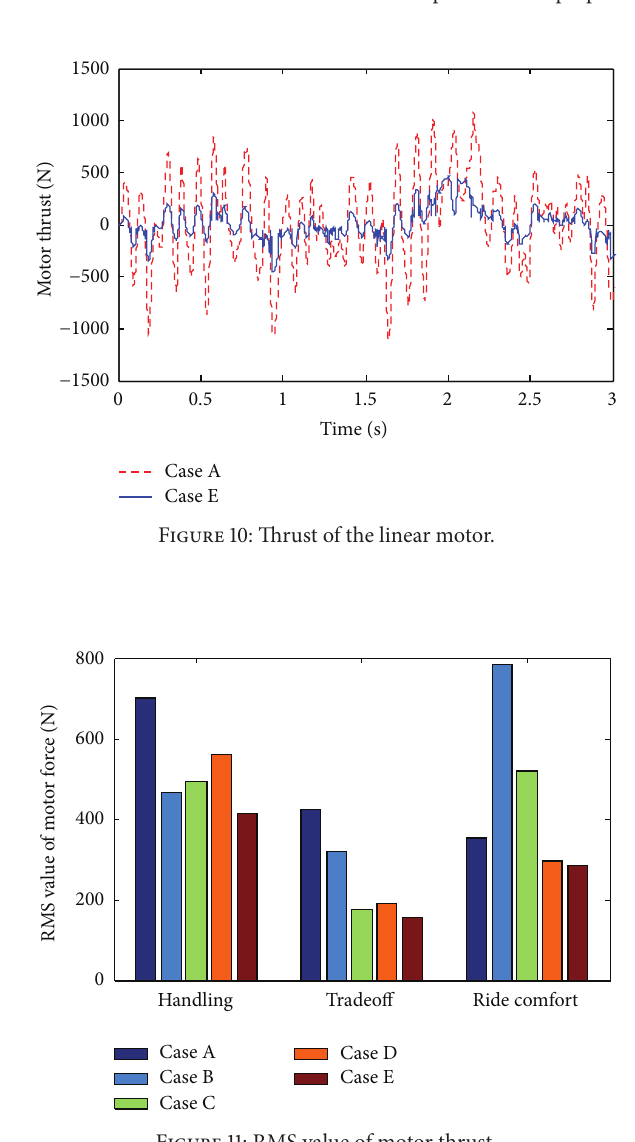
Figure 11: RMS value of motor